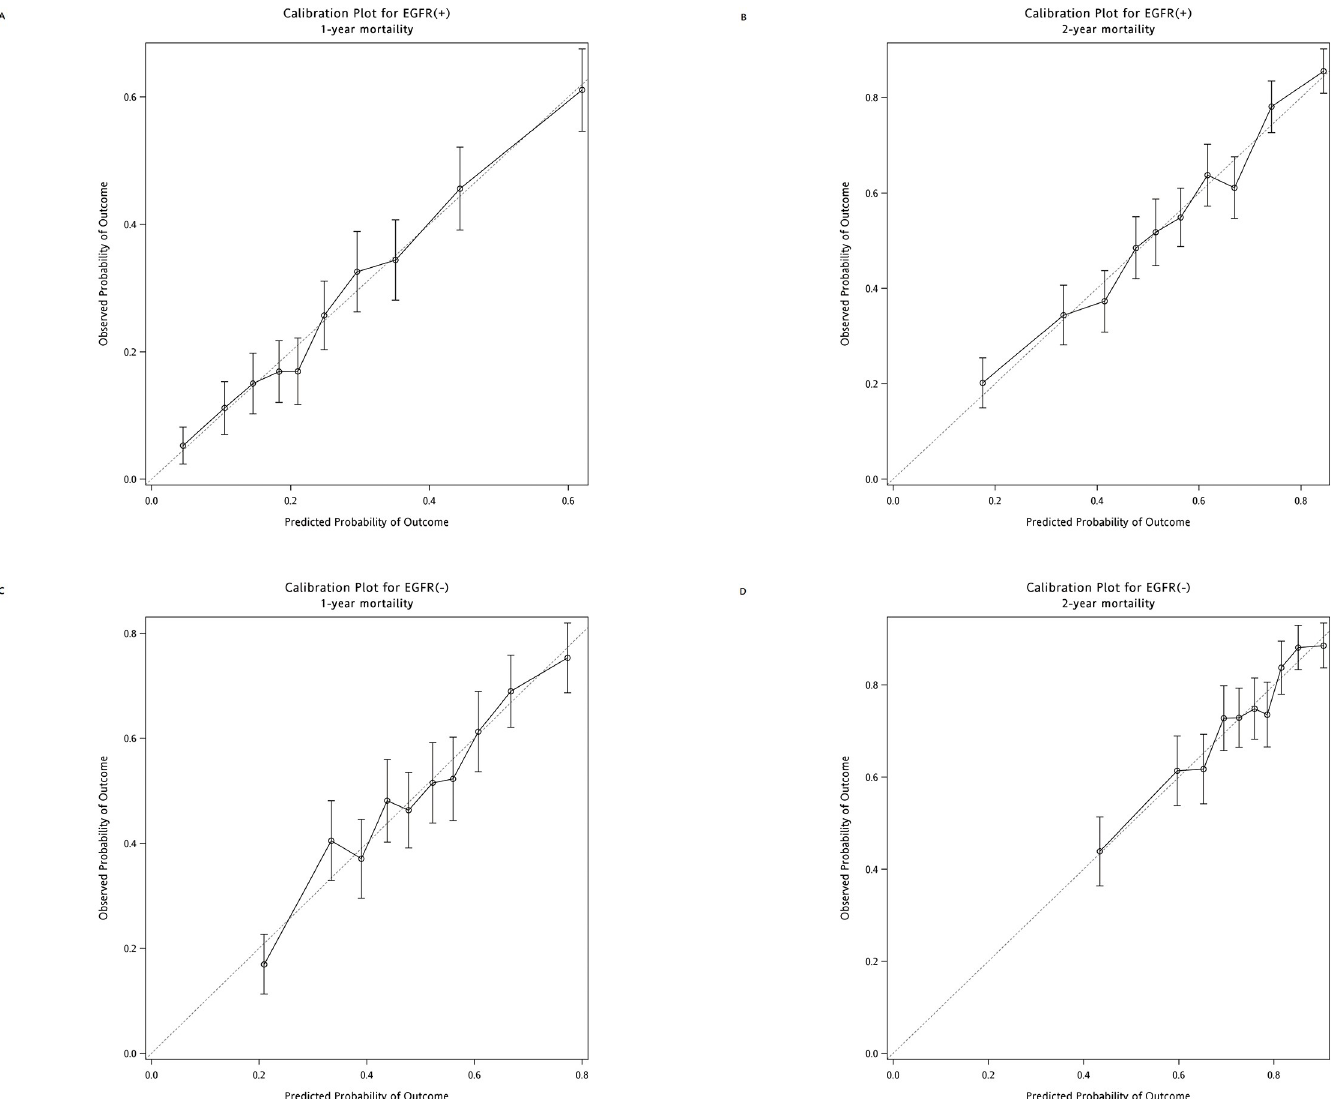
Fig 3. Calibration of nomograms. Calibration curves of the nomogram. (A) 1-year survival probability of EGFR(+) patients. (B) 2-year survival probability of EGFR (+) patients. (C) 1-year probability of EGFR(-) patients. (D) 2-year survival probability of EGFR (-) patient. The calibration curves were close to the 45-degres line.